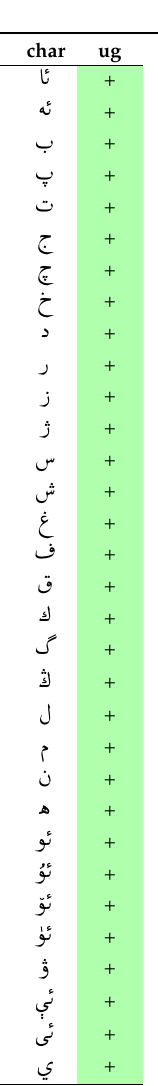
Table 4. Characters of the considered